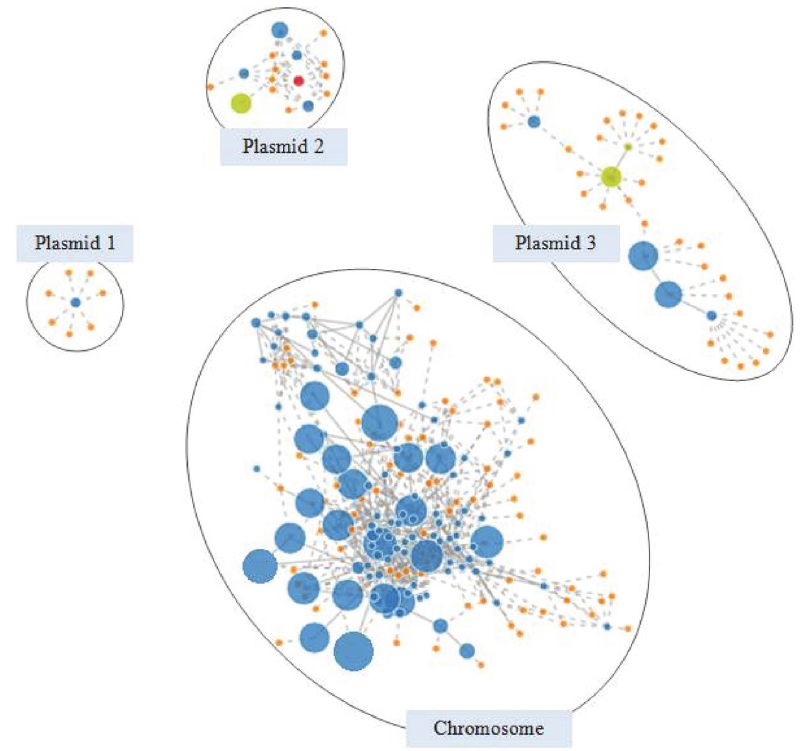
Figure 4. PLACNETw reconstruction of the E. coli C7328 genome. After a manual pruning of the origi- nal network, four components were differentiated: the chromosome, plasmid 1 (small cryptic plasmid), plasmid 2 (IncN replicon) and plasmid 3 (IncR-IncFIA multi-replicon). Contigs are represented as blue nodes of size proportional to their length. Orange nodes indicate reference genomes. Contigs encoding plasmid relaxases and replication proteins are colored in red and yellow,